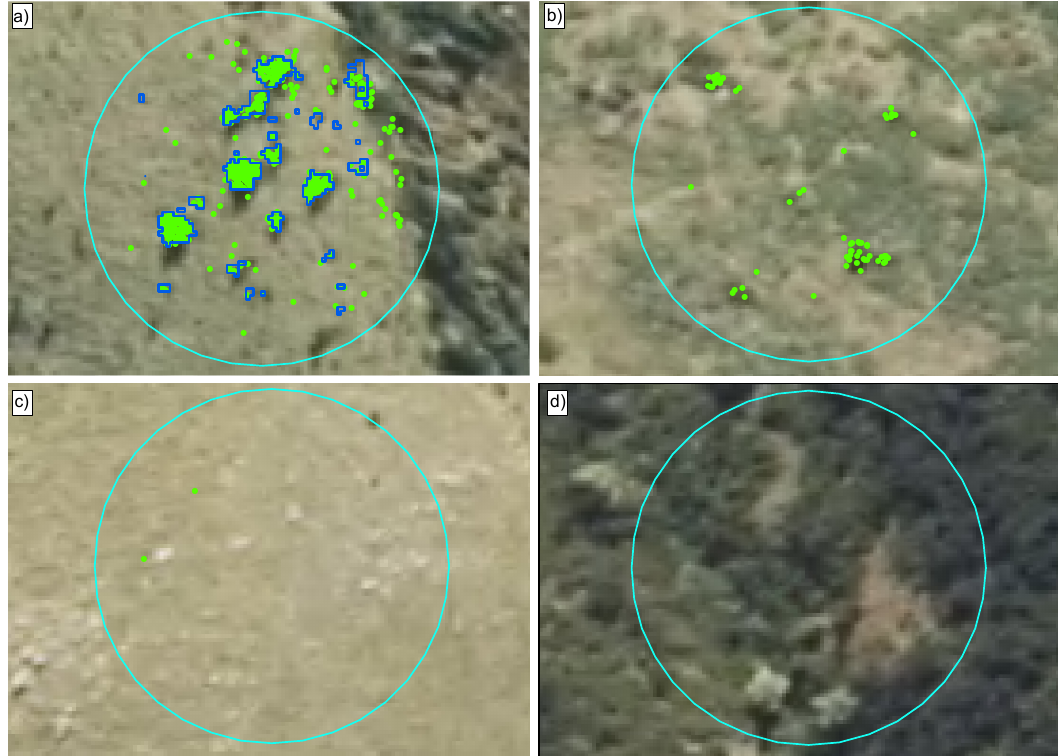
Figure 6. Performance of the RF classifier when applied to the plots shown in Figure 1 containing: ( a ) invasive conifers; ( b ) areas dominated by bracken; ( c ) grassland areas; and ( d ) areas dominated by manuka trees. Invasive conifer classified echoes are shown in light green, and the invasive conifer outlines used to train the model are shown in blue. Echoes not classified as invasive conifers are not